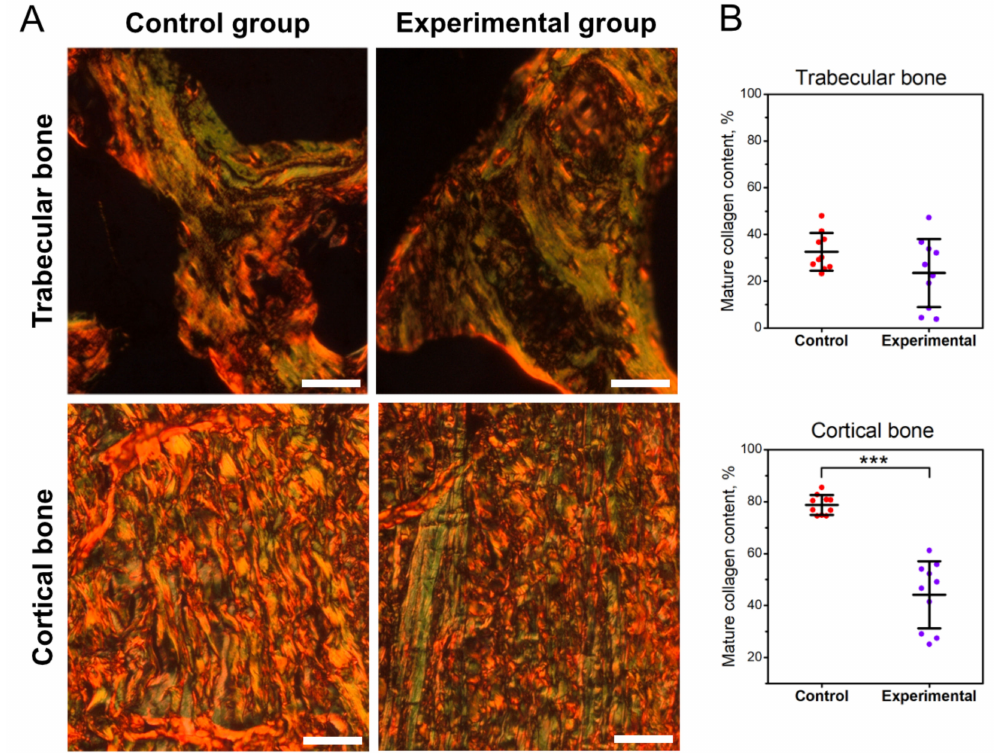
Figure 3. The effect of C. perfringens infection on the bone content of mature collagen in tibia of animals at the age of 42 days: ( A ) representative photos of the PSR staining carried out on formaldehyde- fixed from the trabecular (upper panels) and cortical bone (lower panels) of: mature, thick collagen, which is red or orange, and immature, thin collagen, which is green. All the scale bars represent 10 µ m. ( B ) Content of mature, thick collagen fibers in the trabecular (upper graph) and cortical bone (lower graph) of tibia. Control, the control group of birds; experimental, the experimental group of birds subjected to C. perfringens infection. Data are mean values ± SD (whiskers) from n = 10 birds. Statistical significance: *** p < 0.001 (two-tailed Student’s t -test, t -test with Welch’s correction, or Mann–Whitney U